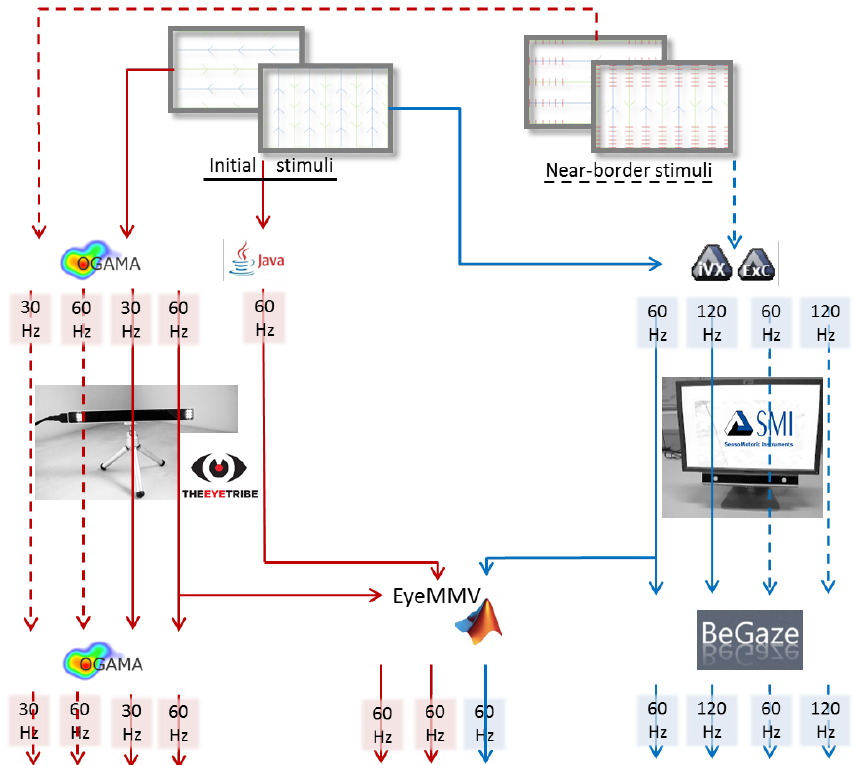
Figure 1: Overview of the experimental set-up and recordings. The solid lines represent trials in which the original stimuli are used; dashed lines correspond to trials in which the near-border stimulus is used. Red lines represent recordings with the Eye Tribe tracker; blue lines recordings with SMI RED. Furthermore, the sampling rate for each recording is mentioned, with an indication of different software packages that are used to record and process the raw